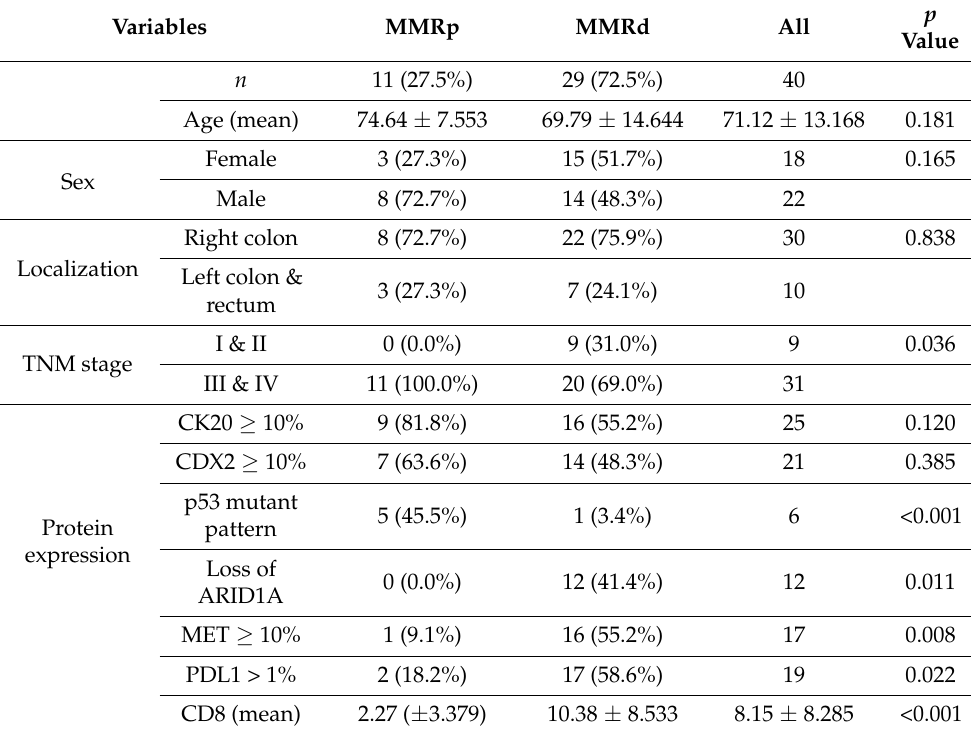
Table 1. Clinicopathological differences between MMRp and MMRd